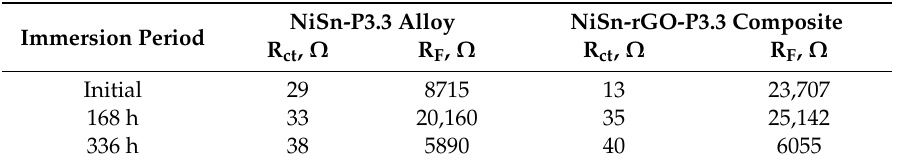
Table 7. Fitting results of electrochemical impedance spectroscopy (EIS) spectra for NiSn-P3.3 alloy and NiSn-rGO-P3.3 composite coatings after exposure to 0.5 M NaCl solution for various times using the proposed equivalent circuit.